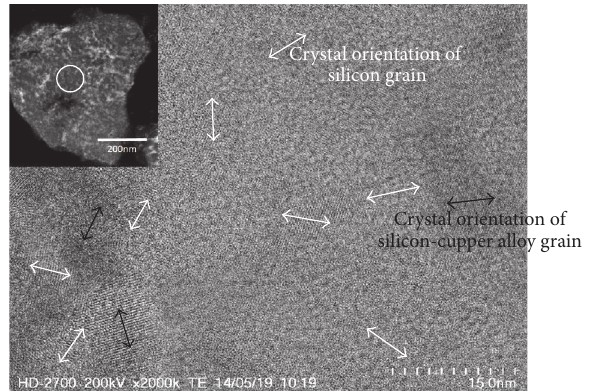
Figure 6: XRD patterns of the Si, H 2 O, and Cu composite after the